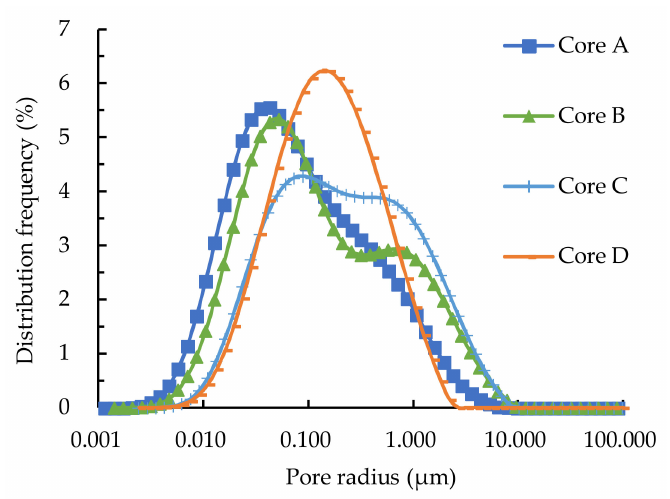
Figure 3. Distribution frequencies of the core pore radius.